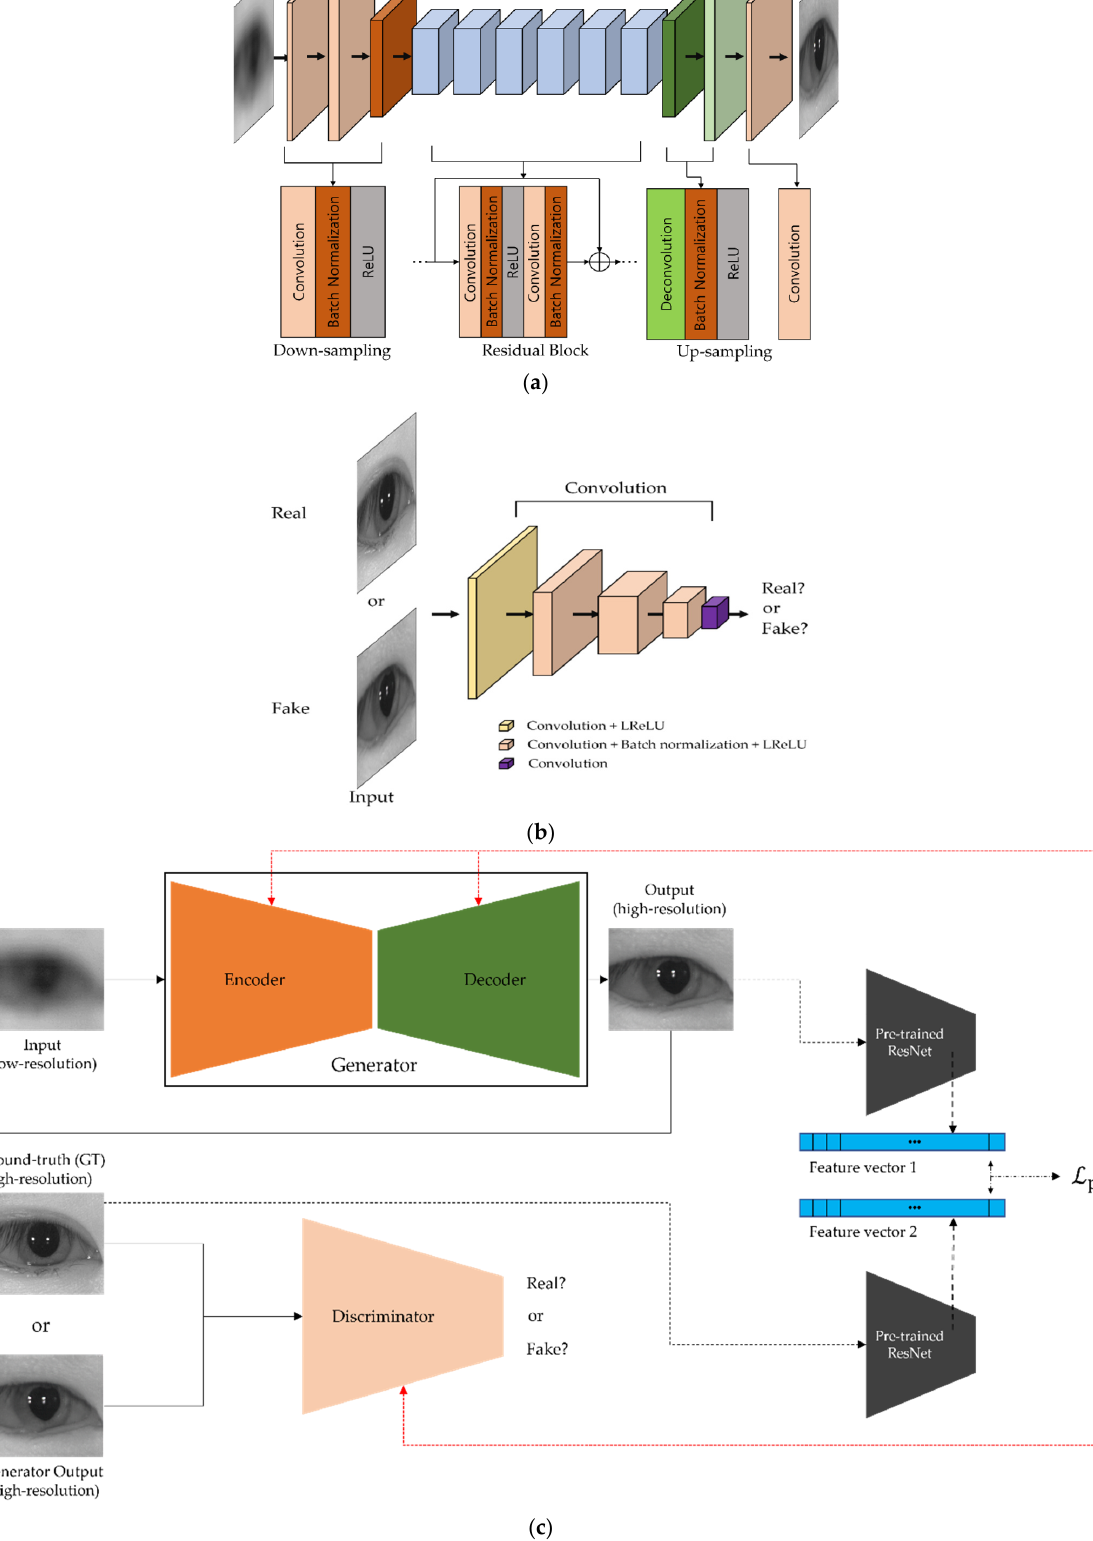
Figure 2. OSRCycleGAN. ( a ) Generator, ( b ) discriminator, and ( c ) whole flow of proposed method with proposed the perceptual loss calculations.